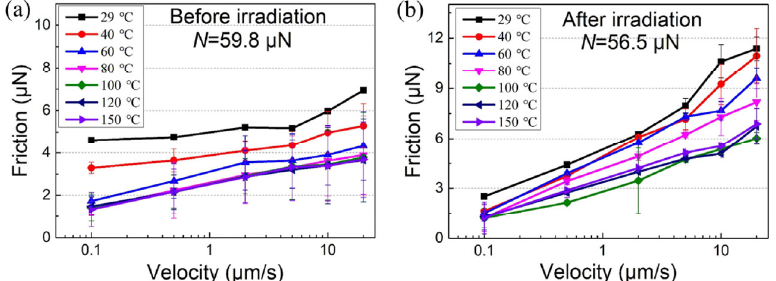
Fig. 2 Velocity dependence of friction at different temperature for mesas not exposed (a) and exposed (b) to Argon plasma irradiation. The slope of the logarithmic dependence of friction on velocity increases after